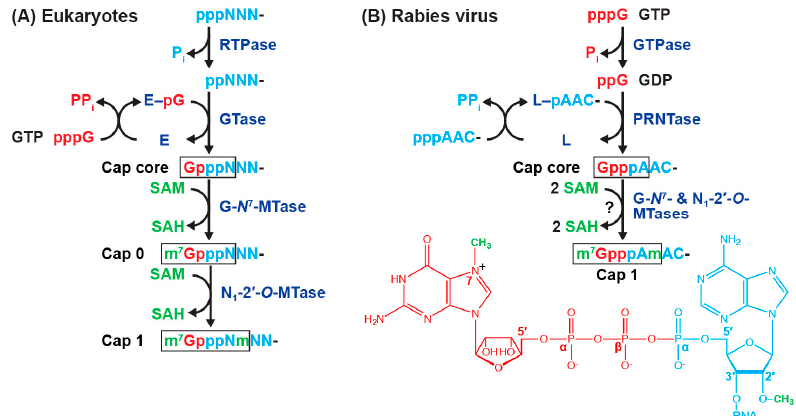
Figure 5. The mechanisms of mRNA capping. Pathways of the mRNA cap formation in higher eukaryotes ( A ) and rabies virus (RABV) ( B ) are represented. RNA (pppNNN- / AAC-), GTP (pppG), and S -adenosyl-L-methionine (SAM) are shown in light blue, red, and green, respectively. P i , PP i , and SAH indicate inorganic phosphate, inorganic pyrophosphate, and S -adenosyl-L-homocysteine, respectively. Enzymes are: RTPase, RNA 5 ′ -triphosphatase; GTase, mRNA guanylyltransferase (shown by "E"); GTPase, guanosine 5 ′ -triphosphatase; PRNTase, GDP polyribonucleotidyltransferase (shown by "L"); G- N 7 -MTase, mRNA (guanine- N 7 )-methyltransferase; N 1 -2 ′ - O -MTases, mRNA (nucleoside 1 -2 ′ - O -)-methyltransferase. Note that two methylation reactions by RABV enzymes have not been demonstrated. In ( B , bottom), parts of the cap 1 structure formed with the RABV enzymes are colored differently based on their origins (GTP, RNA, and SAM).